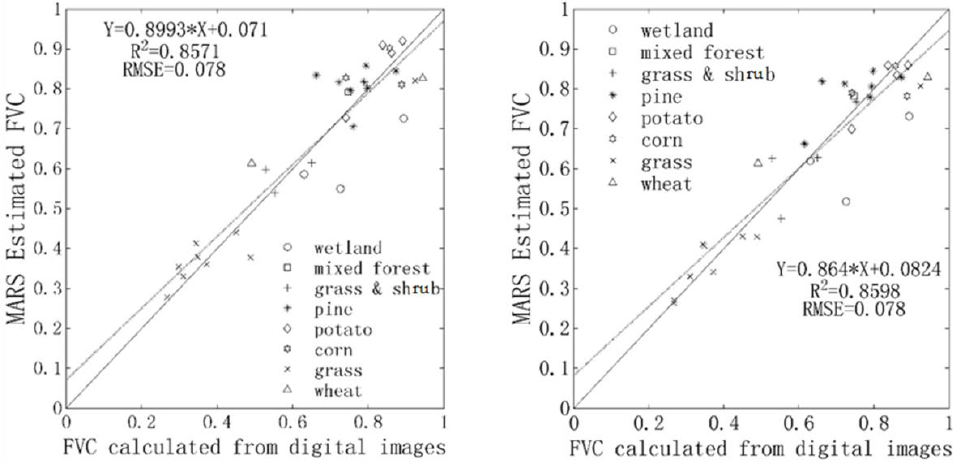
Figure 8. Scatter plots of the estimated FVC from: Landsat 7 ETM+ ( left ); and Landsat 8 OLI ( right ) reflectance data using the proposed algorithm and FVC extracted from the field photos in Chengde area.